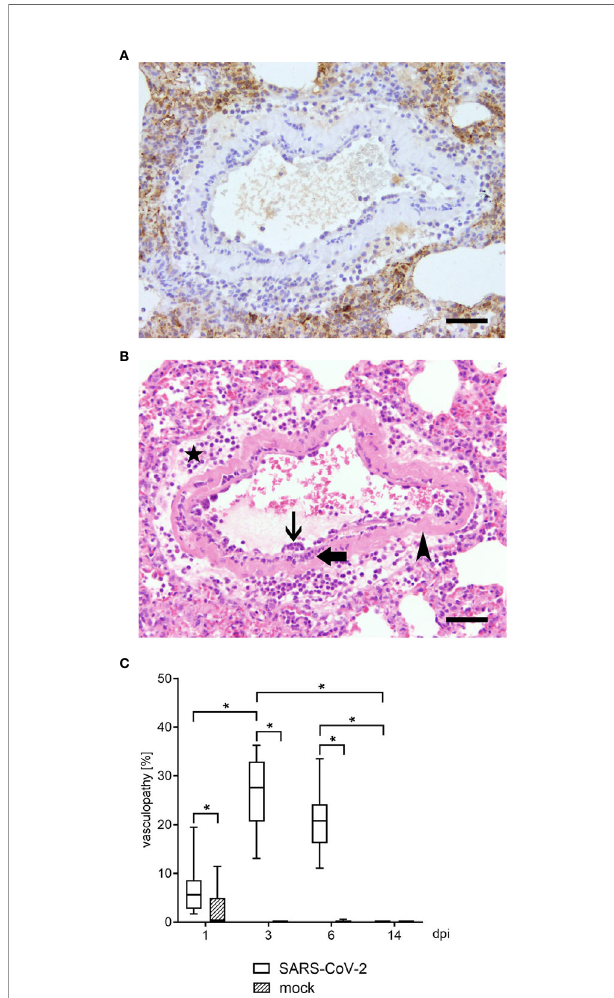
FIGURE 1 | Vascular lesions and virus protein were identi fi ed by histological and immunohistological examination in lungs of hamsters 3 dpi. Representative pictures of light microscopic pulmonary fi ndings are presented (3 dpi). (A) While viral antigen expression was detected in lung lesions (dark brown coloration), none was present in affected blood vessels. Immunohistochemistry for SARS- CoV-2 nucleoprotein, avidin – biotin complex -method, 3,3 ’ -diaminobenzidine, light microscopy, scale bar 50 µm. (B) An affected blood vessel shows endothelium which is bulging into the lumen due to an in fi ltration by macrophages and lymphocytes (endothelialitis; thin arrow). Further, in fl ammatory cells, mainly macrophages and neutrophils were present within the vessel wall (vasculitis; thick arrow). Segmentally, the vessel wall shows hypereosinophilia and loss of cellular details (arrowhead). Additionally, perivascular edema and perivascular in fi ltrates, consisting of macrophages and neutrophils, were present (star). Hematoxylin and eosin stain. 200 x. Hematoxylin and eosin, light microscopy, scale bar 50 µm. (C) Vasculopathy including endothelial hypertrophy, endothelialitis and vasculitis was quanti fi ed within the lungs of SARS CoV-2 or mock infected animals using hematoxylin and eosin (H&E) staining. At 1, 3 and 6 dpi SARS CoV-2 infected animals showed a signi fi cant increase of vascular alterations compared to controls. Furthermore, vasculopathy was signi fi cantly increased at 3 dpi compared to 1 and 14 dpi in SARS-CoV-2 infected hamsters. Also, at 6 dpi vascular alterations remained increased compared to 14 dpi. At 14 dpi no vasculopathy could be observed. Data are shown as box-and-whisker plots with mean and quartiles. Signi fi cant differences between the groups obtained by Kruskal-Wallis test followed by Mann – Whitney U or Bonferroni post hoc test were indicated by *p <